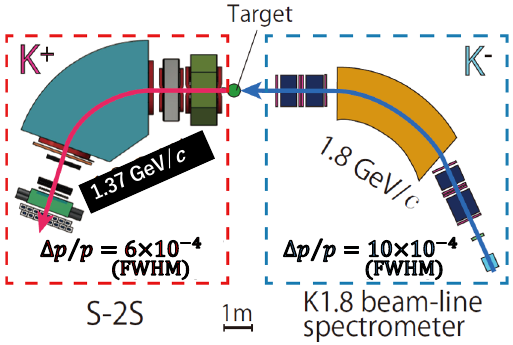
Fig. 1. Experimental setup of the J-PARC E70